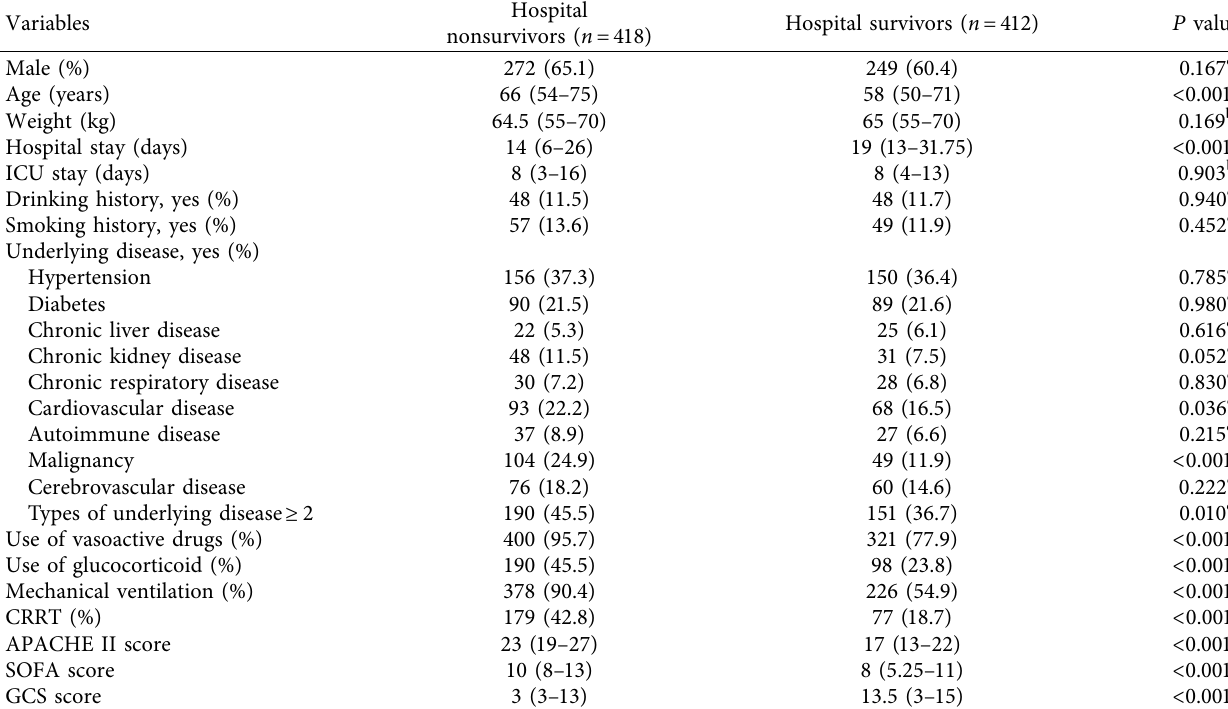
Table 1: Te comparison of baseline data between hospital survivors with